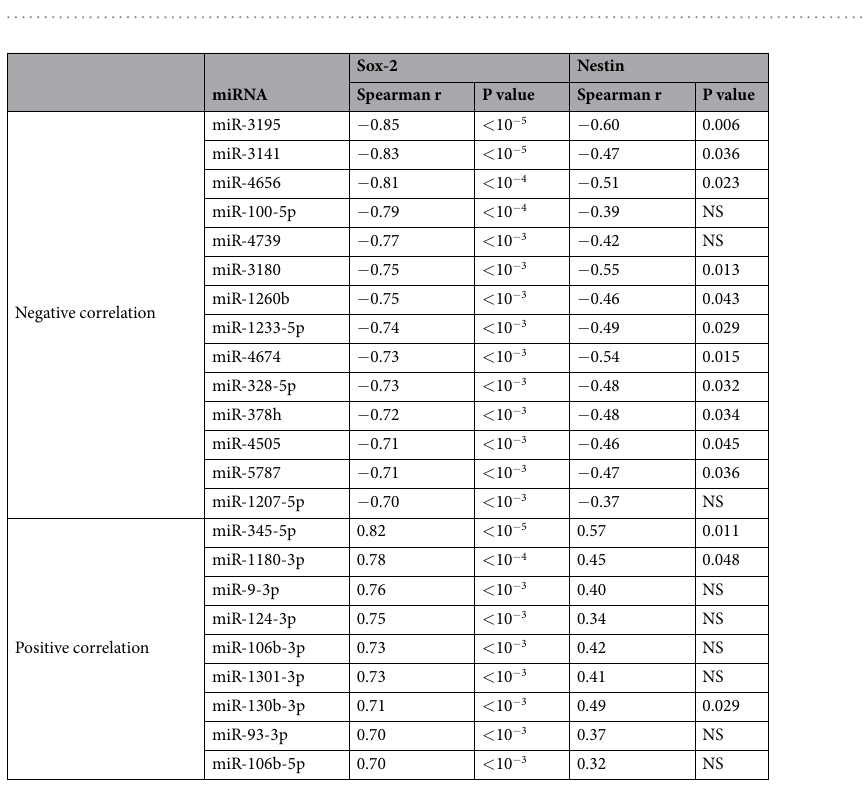
Table 1. MiRNAs correlating with Sox-2 and nestin expression in paired primary GBM cell